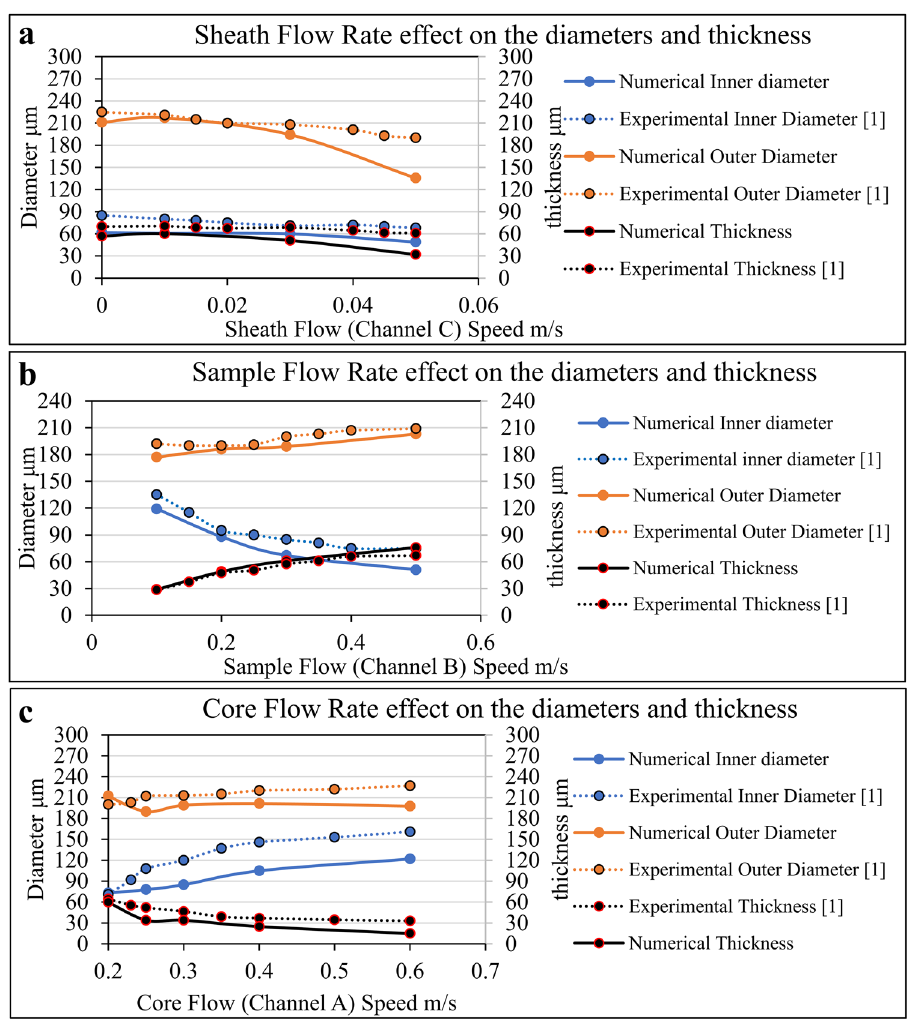
Figure 4. Experimental results of the hollow microfiber inner/outer diameters and thickness for ( a ) sheath flow effect, ( b ) sample flow effect, and ( c ) core flow effect 1